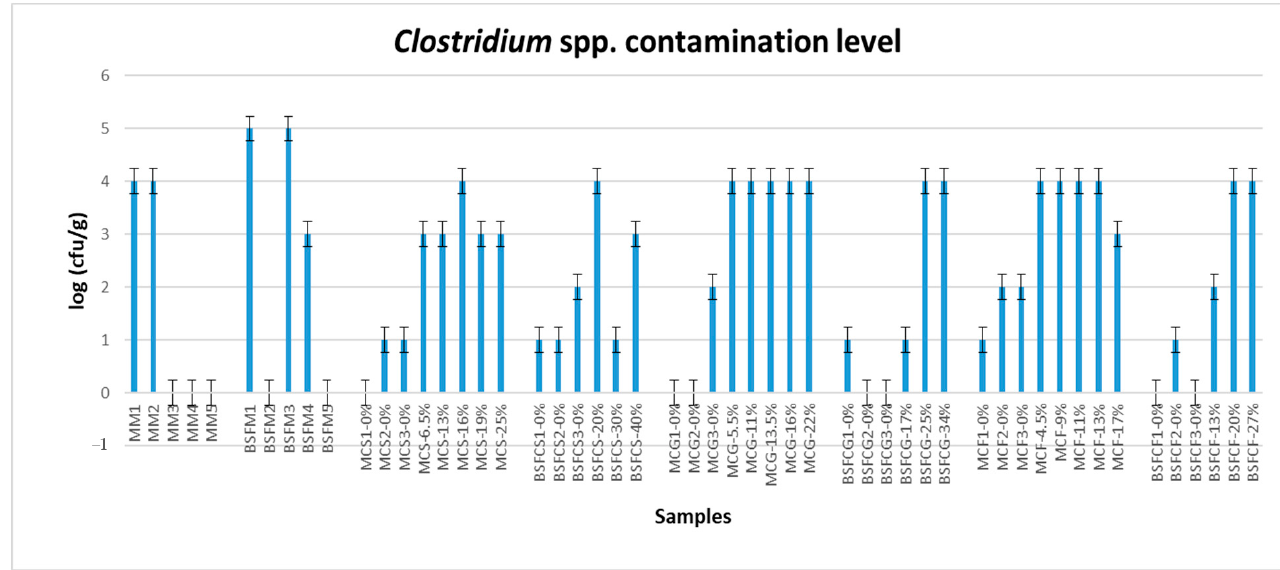
Figure 1 . Contamination level of the processed animal protein (PAP) and experimental feed samples by Clostridium spp. cfu: colony-forming units. Table 7. Statistical significance of the IPAP addition origin on the Clostridium spp. level in feed